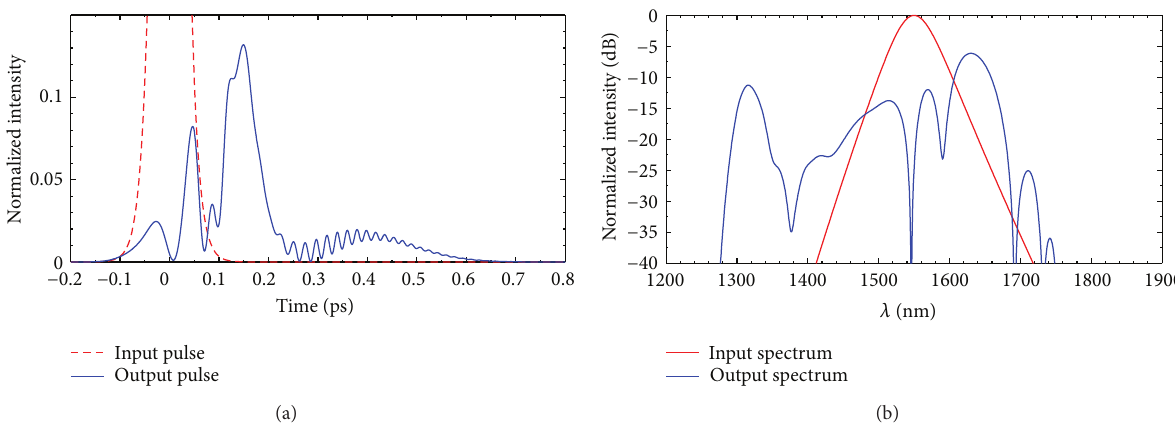
Figure 3: (a) Input and output temporal properties obtained from propagating the 50 fs (FWHM), 25 W peak power input hyperbolic secant soliton. (b) Input and output spectral properties obtained from propagating the 50 fs (FWHM), 25W peak power input hyperbolic secant soliton. The soliton order is 𝑁 = 3 and waveguide length is 1 cm.